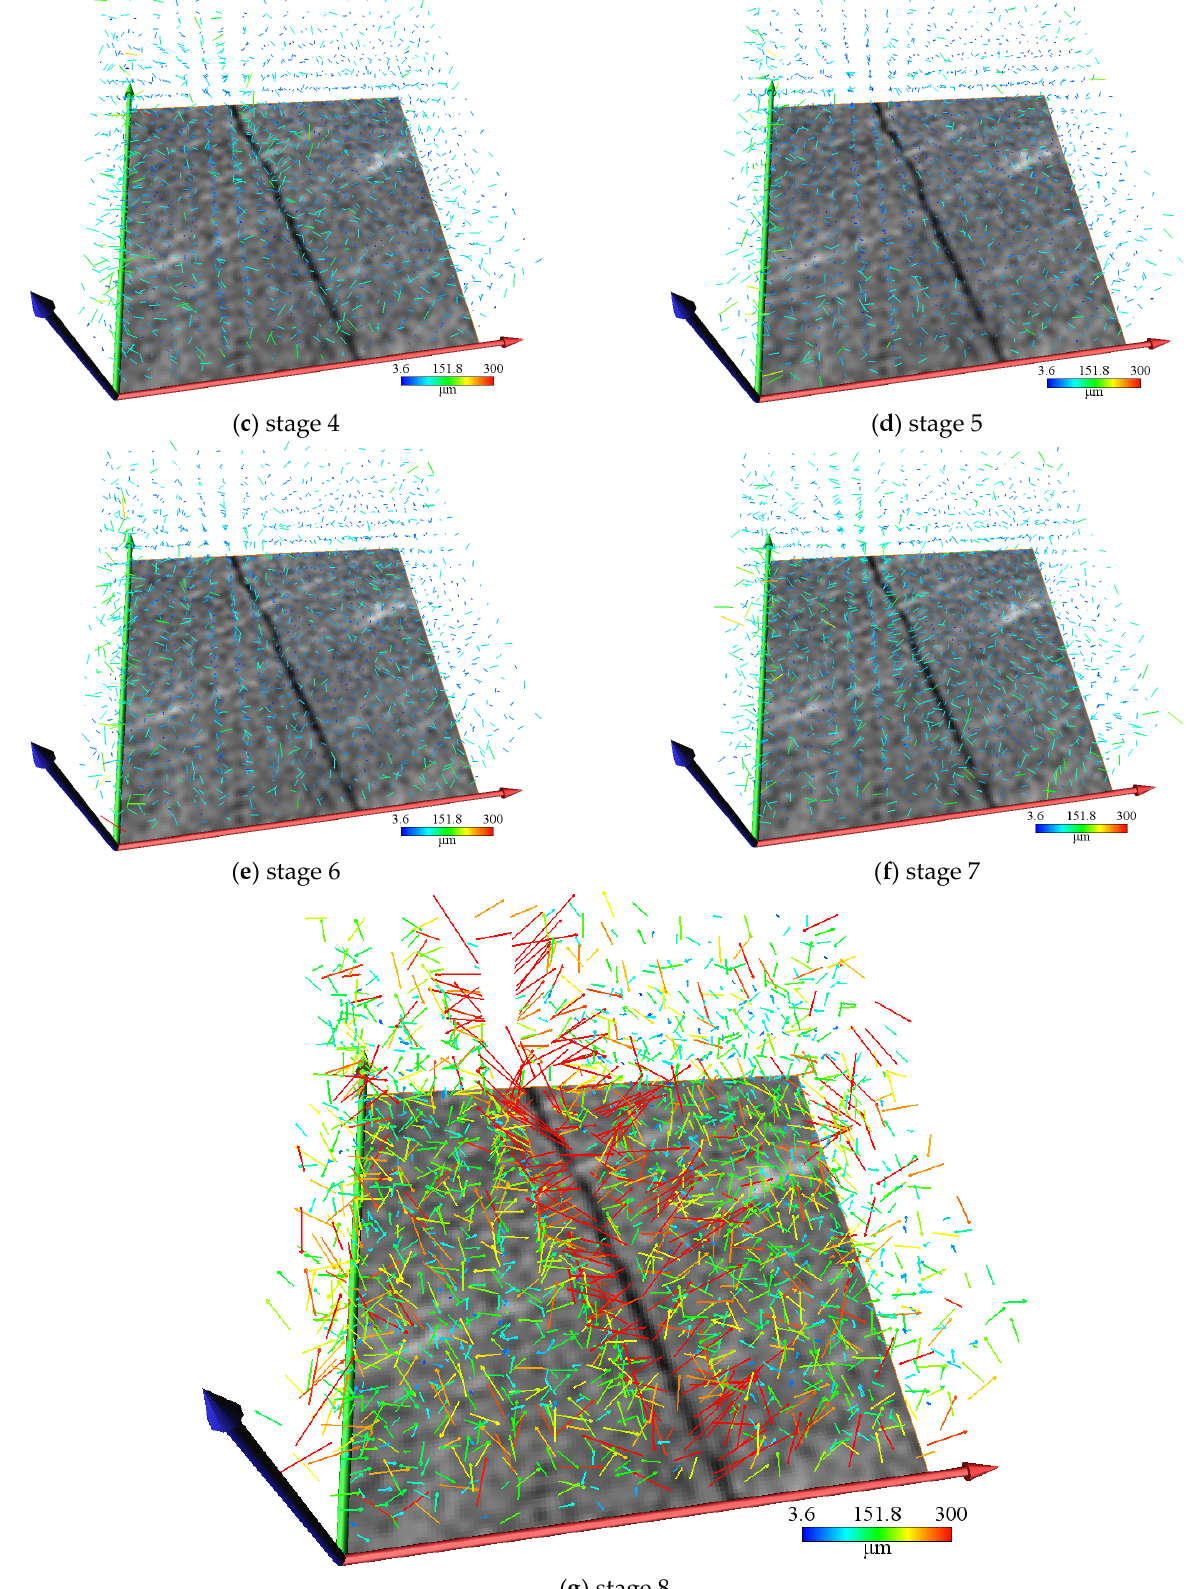
Figure 7. Calculated 3D displacement field at different stages of ROI1.